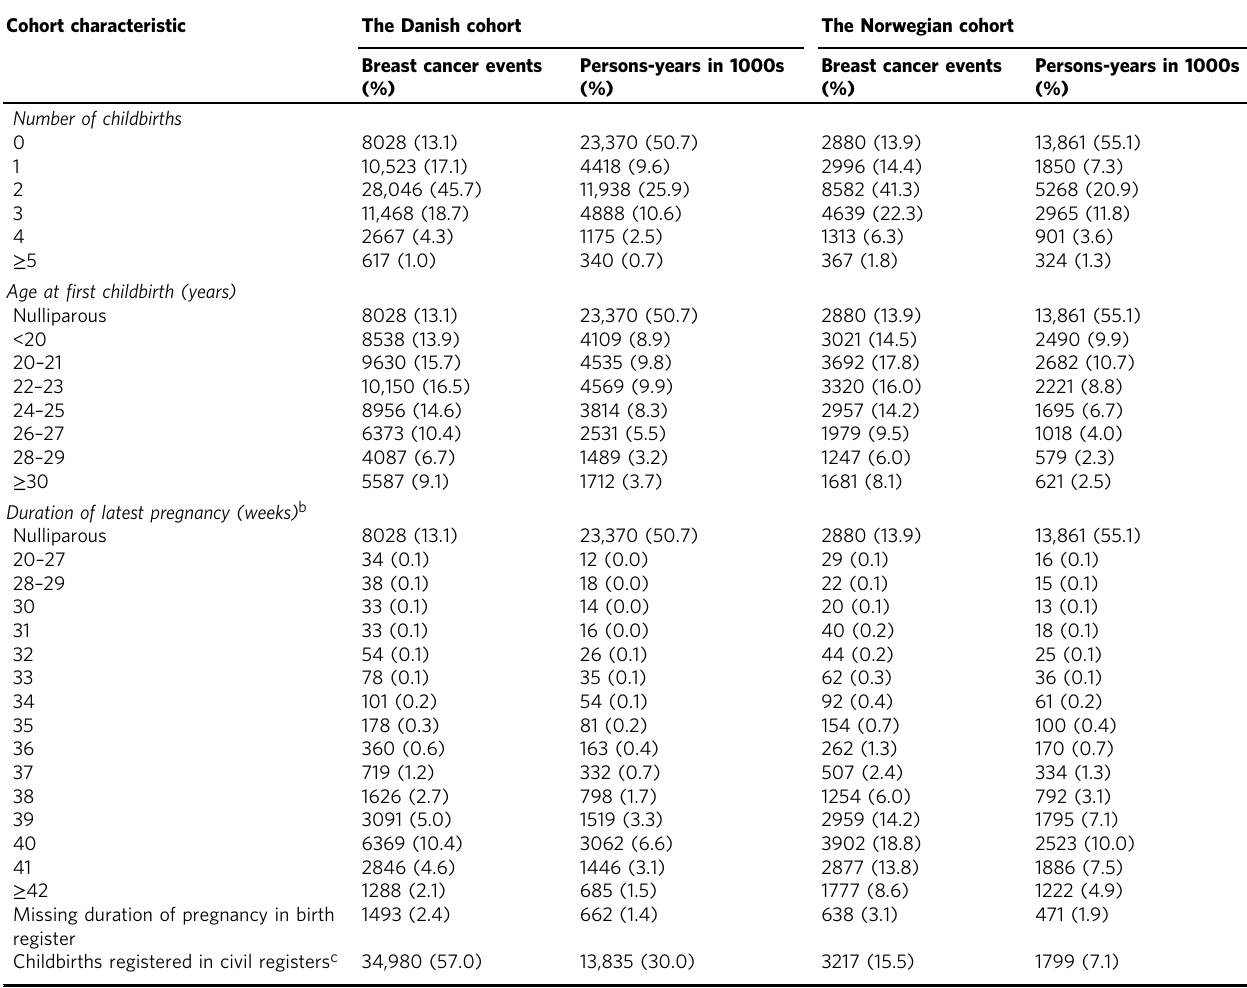
Table 1 Breast cancer events and person-years according to number of childbirths, age at fi rst childbirth, and duration of latest pregnancy in the Danish and the Norwegian cohort a Cohort characteristic The Danish cohort The Norwegian